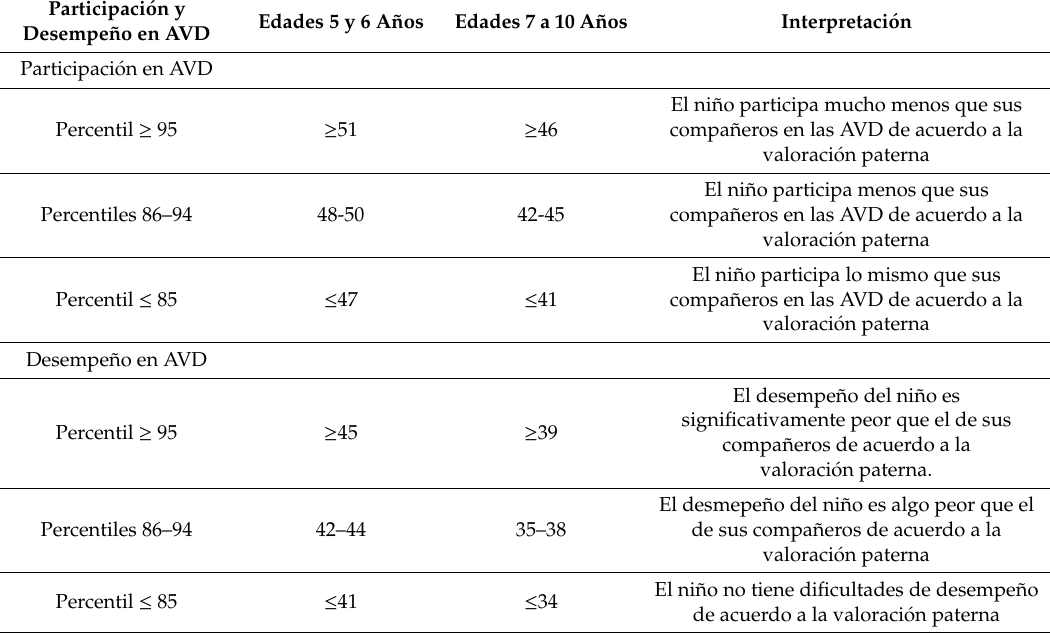
Table A1. Spanish cut o ff values and interpretation for the total scores on the “Participation” and “Performance” scales of the